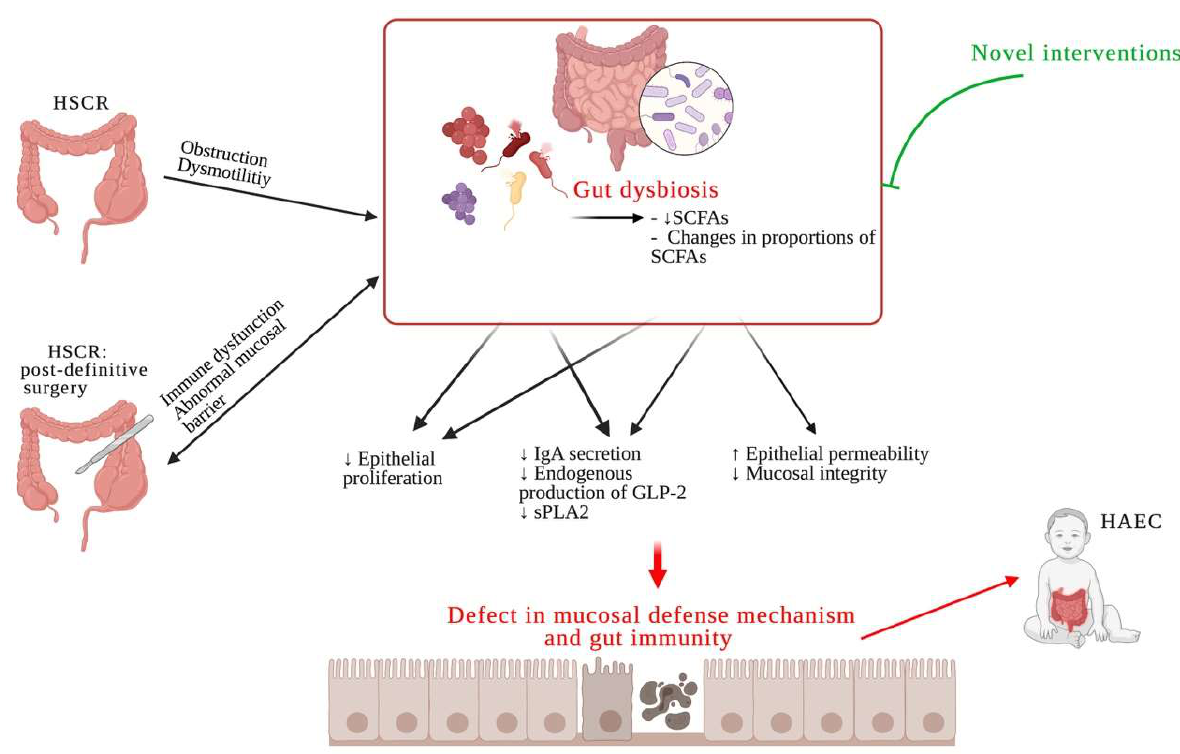
Figure 1. Gut microbiota dysbiosis in Hirschsprung disease and Hirschsprung-associated enterocolitis (Figure description as Appendix A).